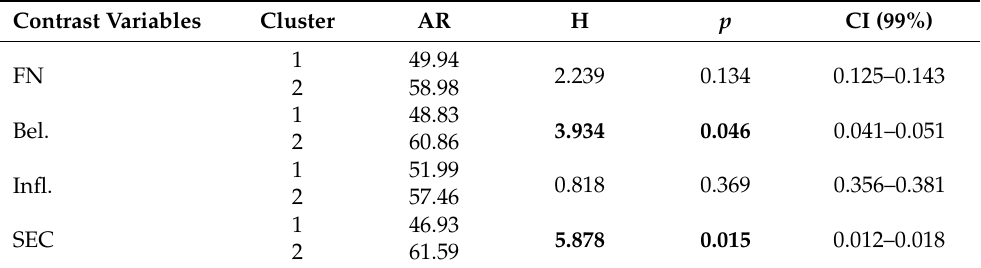
Table 4. Non-parametric tests for assessing the homophily hypothesis.